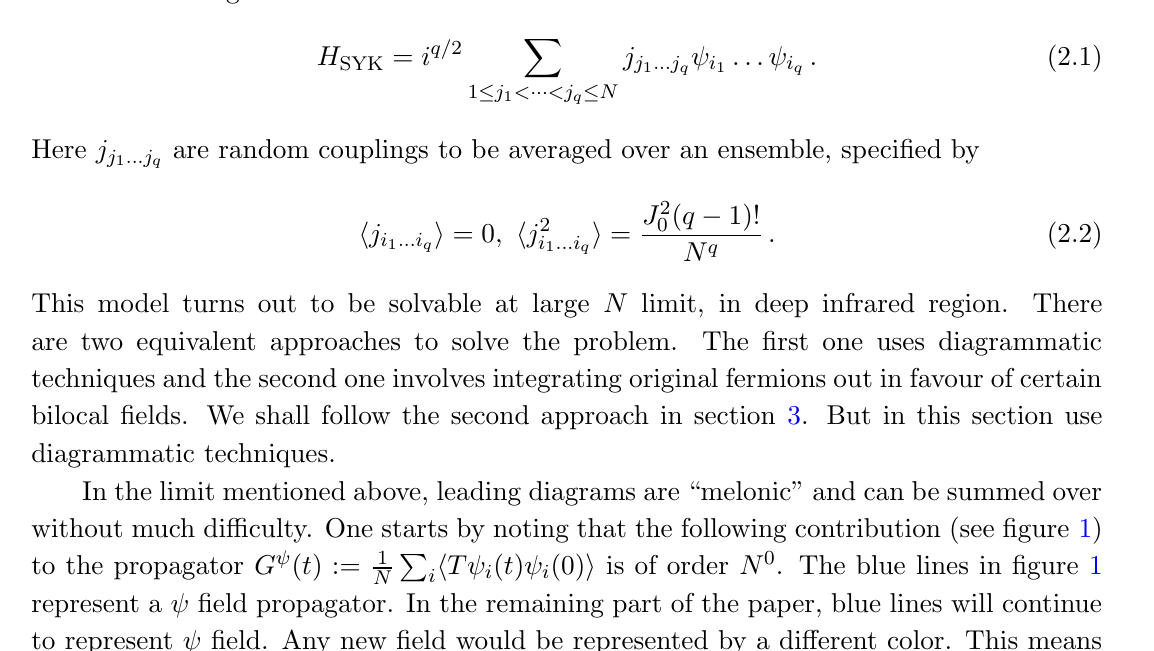
Figure 1 . Leading contributions to the propagator in large N